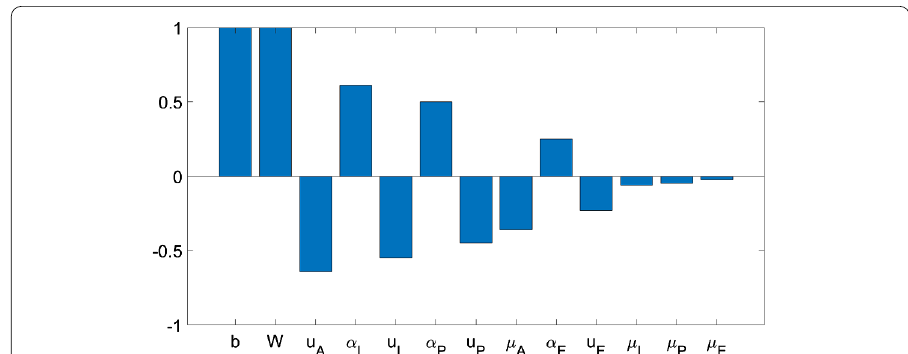
Figure 2 Sensitivity analysis of the basic reproduction number R 0 with respect to model parameters. Baseline values used given in Table 2. The exact numerical indices are also presented in Table 1, whereas control parameters are set to u E = u L = u P = u A = 0.3. Overall, we can note that model parameters b and W are highly correlated with R